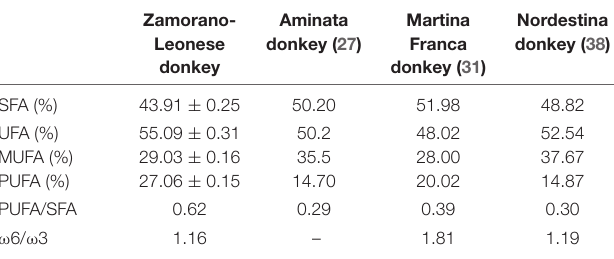
TABLE 6 | Distribution of the fatty acid profile and different nutritional indexes to TABLE 5 | Proximate composition of our sample of Zamorano-Leonese donkey assess the quality of the fatty acid profile in the milk of the Zamorano-Leonese milk compared to other milk species. donkey compared to other Donkey Human Cow Goat (34, Sheep Camel Mare (22) (33) 36) (36) (35) (37) Moisture (%) 90.95 ± 0.42